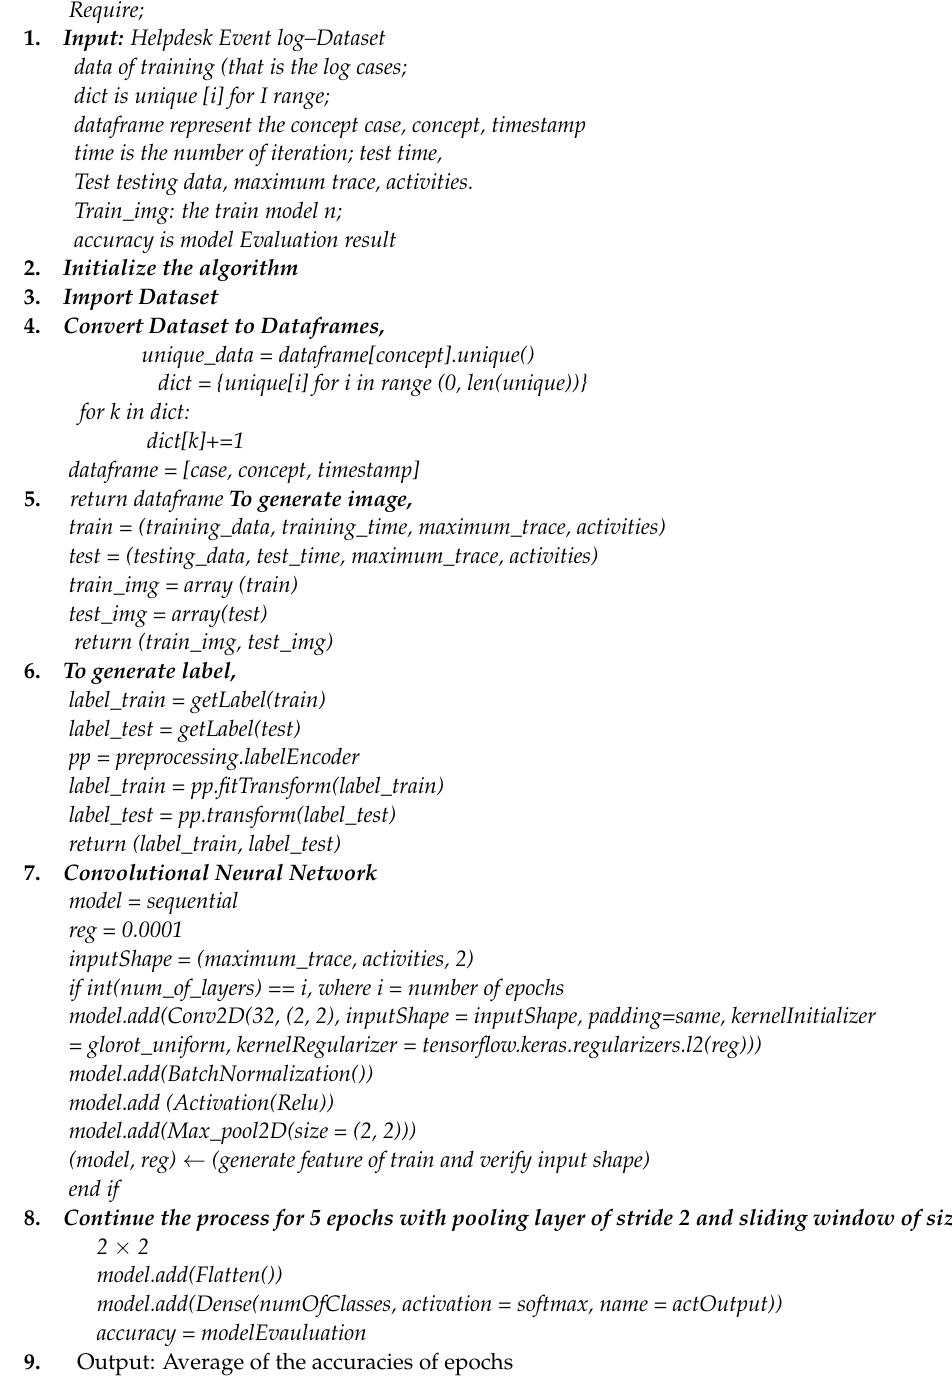
Algorithm 1: CNN-based next activity